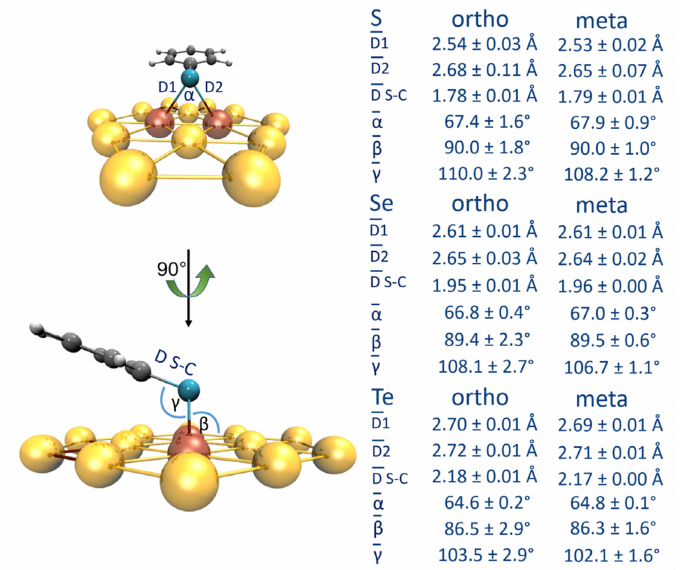
Figure 2. Graphic representation of the principal geometric parameters obtained for the systems with the substituent R in the ortho and meta positions (hydrogen-white, carbon-grey, gold-yellow and orange,